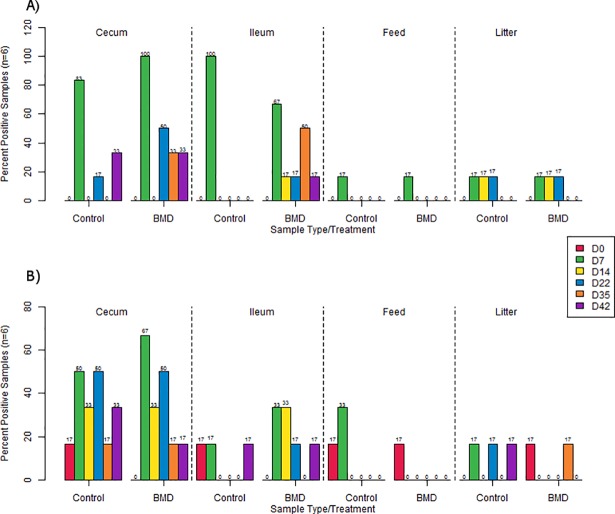
Prevalence of food borne pathogens in cecum, ileum, litter and feed collected at different time points (d0, 7, 14, 22, 35, 42) from BMD-free and BMD supplemented groups.(A) Prevalence (in %) of Salmonella and (B) Prevalence (in %) of Campylobacter.